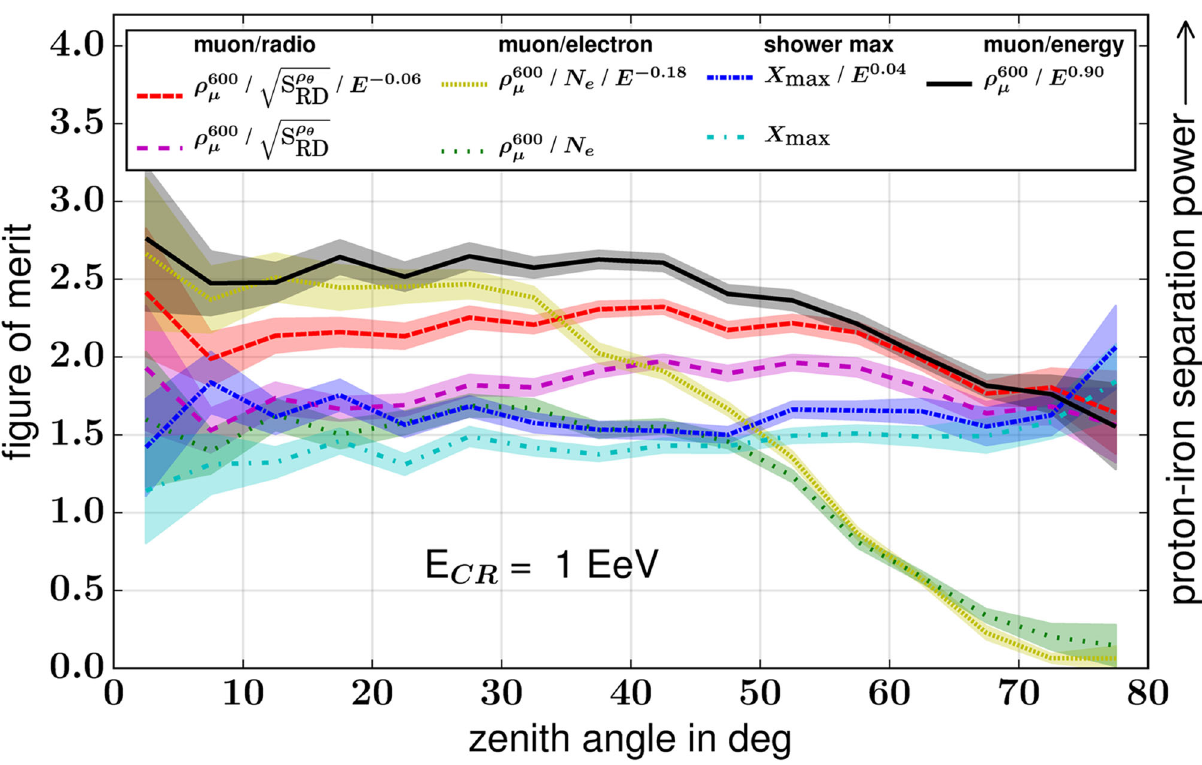
Fig. 11 Figure of merit of the different shower observables. The dif- ferent mass estimators are corrected for their dependence on the true primary energy, which is known as input parameter of each simulation. In addition, the uncorrected ratios are shown providing a more realistic estimate of the potential for real air-shower arrays. The bands depict